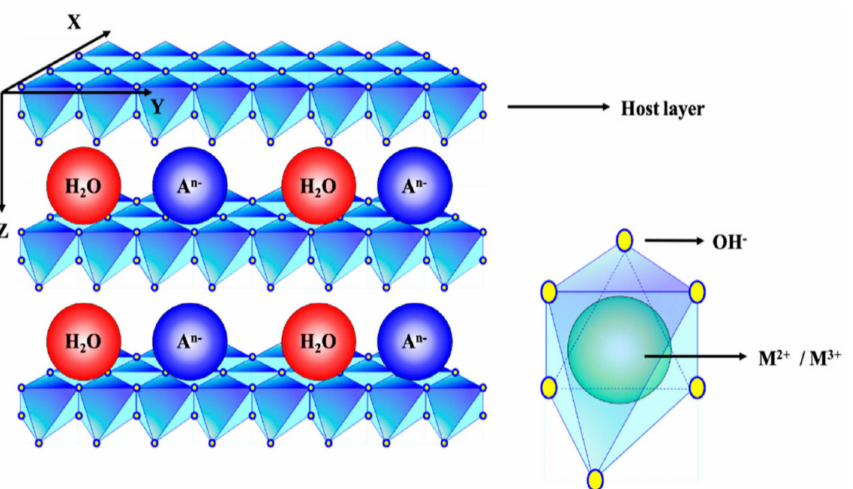
Figure 1. The structure of LDH is composed of a 2D, inorganic, brucite-like structure. Layered hydroxide has a similar structure, but only composed of M 2+ instead of M 2+ /M 3+ in the LDH. The counter anion, A n- together with water molecules are present in the inorganic interlayer